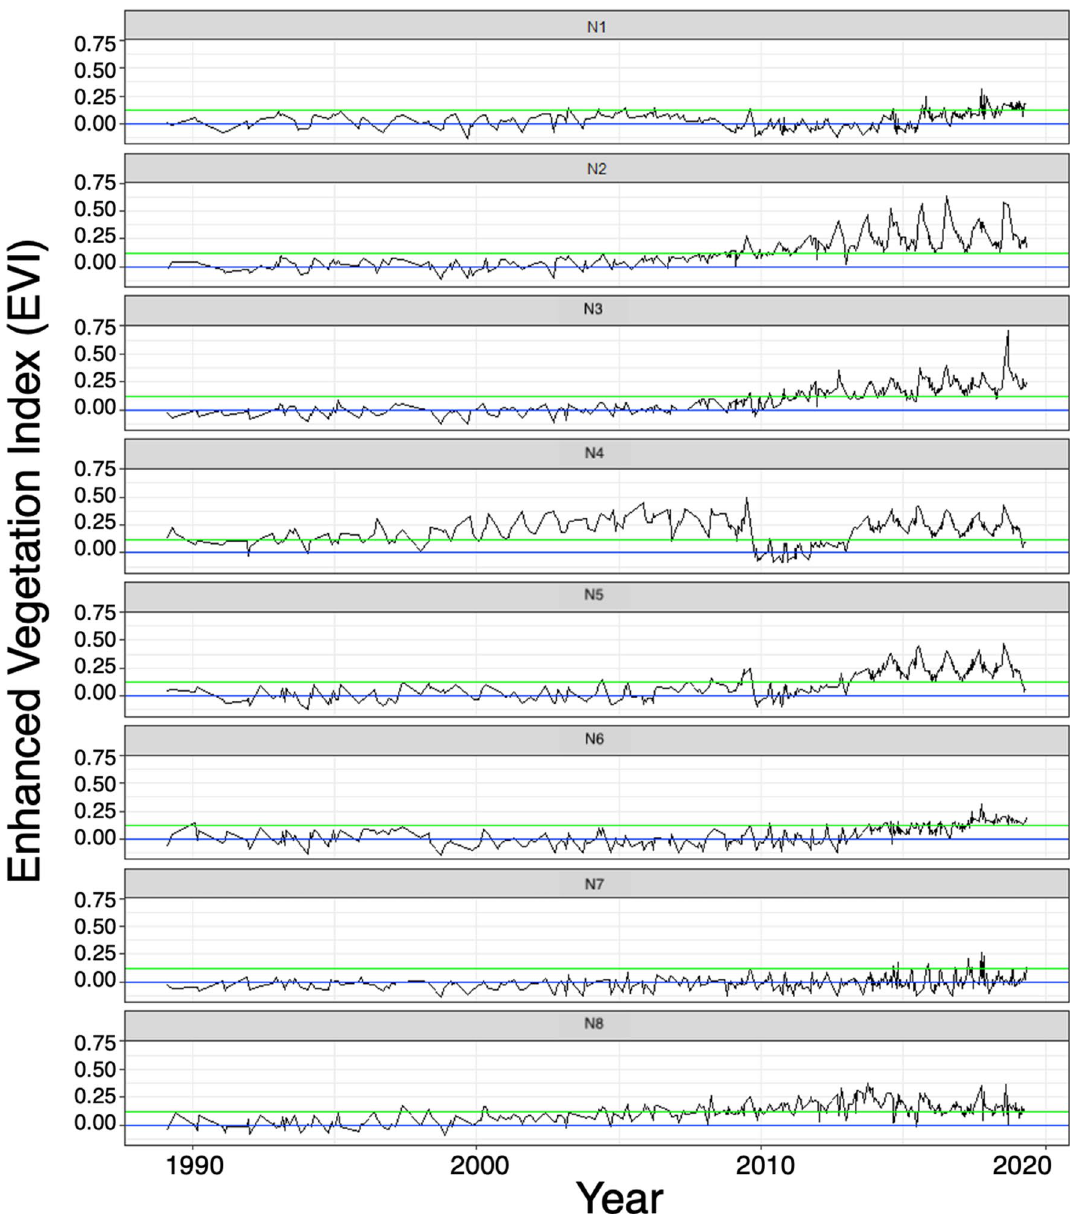
Figure 5. Habitat dynamics of gharial nesting sites from 1988 to 2019 in KWS. The EVI ( y- axis) below the blue line represents water submerged habitat, between blue and green line represents mosaic of sand and grass (“sandy grasslands”), and above the green line represents mixture of shrubs and trees (“woody vegetation”). A habitat shift was observed across most of the sites around the year 2010, from which point the habitat gradually converted into woody